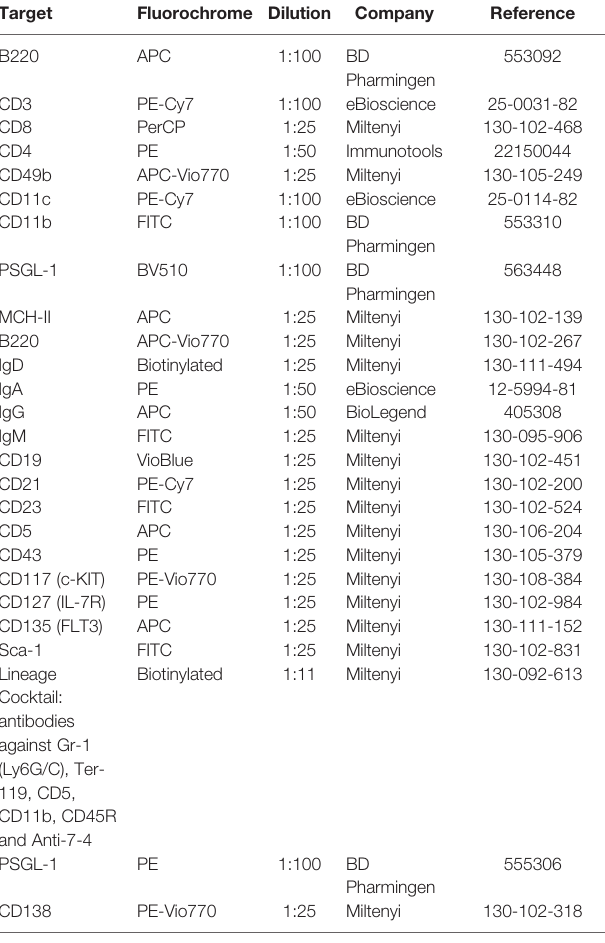
TABLE 2 | Flow Cytometry Antibodies for characterization of murine immune cells. Target